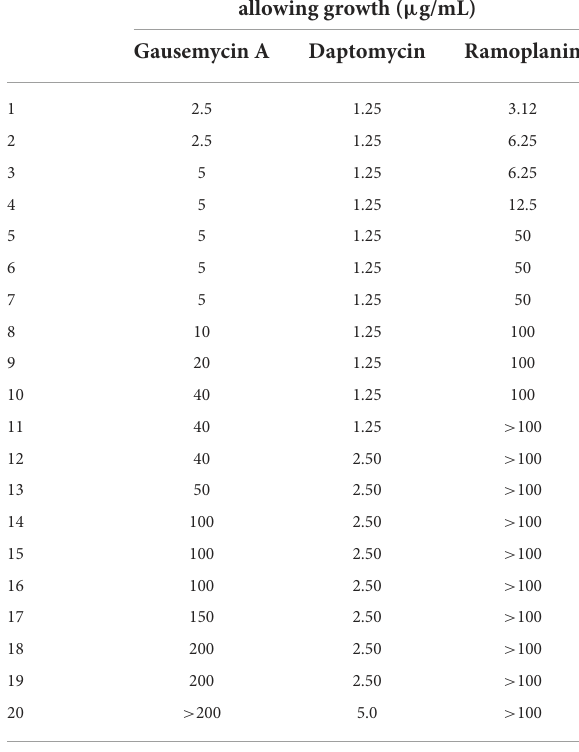
TABLE 1 The serial passaging of S. aureus FDA209P in increasing concentrations of antimicrobials. Passage # The highest concentration of antibiotic allowing growth ( µ g/mL)